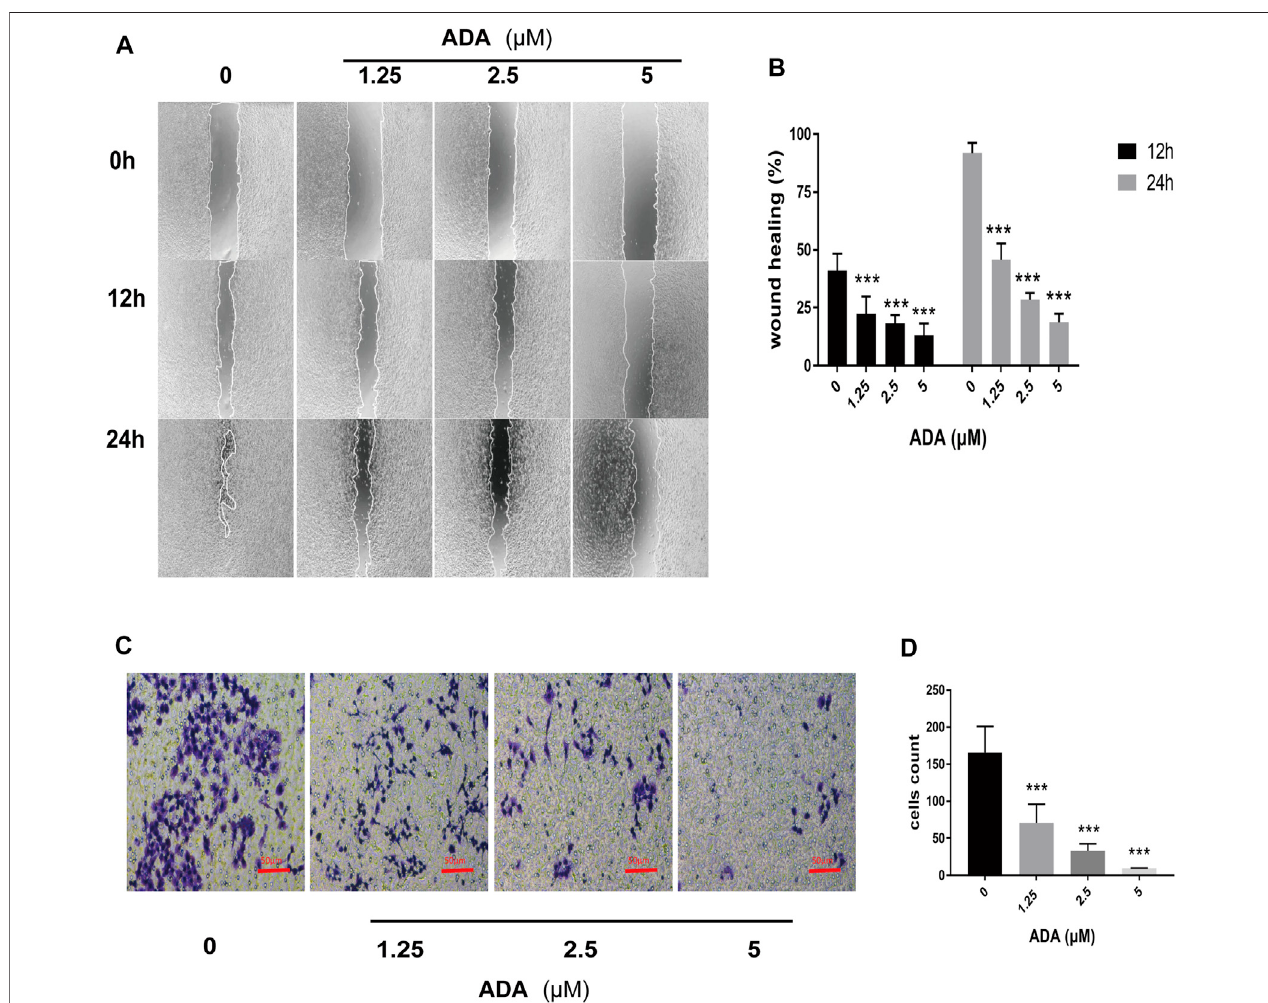
FIGURE2| ADAsuppressedthemigrationand invasionofRM-1 cells. (A,B) Thehealingeffect and migrationofRM-1cellswasdeterminedusingthescratchtest. AftertreatmentwithvaryingconcentrationsofADA for12or24 h, thedegree ofwound healingofthecellswasmeasured (40×). (C,D) Theratioofinvasion ofRM-1 cells was further determined using Transwell assay. After treating cells with varying ADA concentrations for 24 h, the proportion of invaded cells was stained and calculated (200×), Data are articulated as mean ± standard deviation. (* p < 0.05, ** p < 0.01,*** p < 0.001 vs. control).